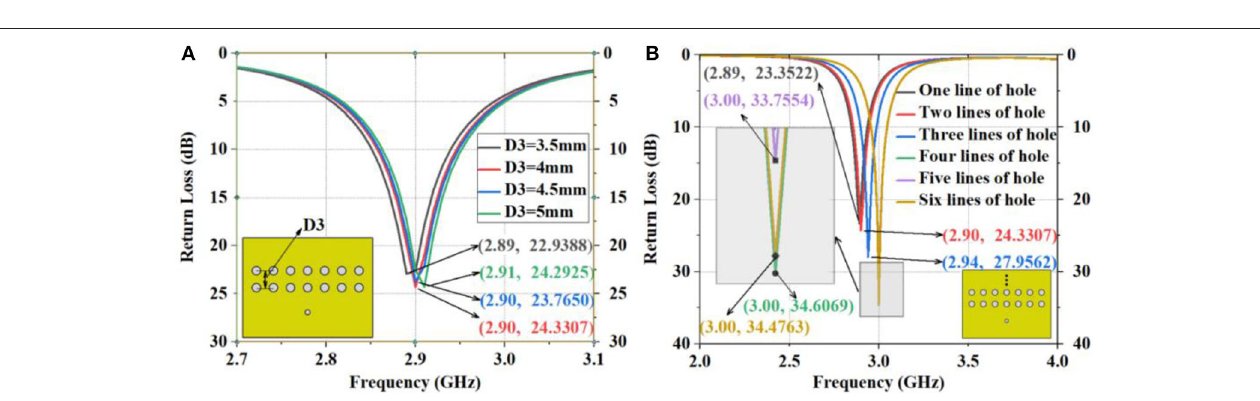
FIGURE 4 | The simulation of return loss of the antenna with one-line drilled holes on the patch center. (A) Different dimensions of R2, (B) Different dimensions of D2.